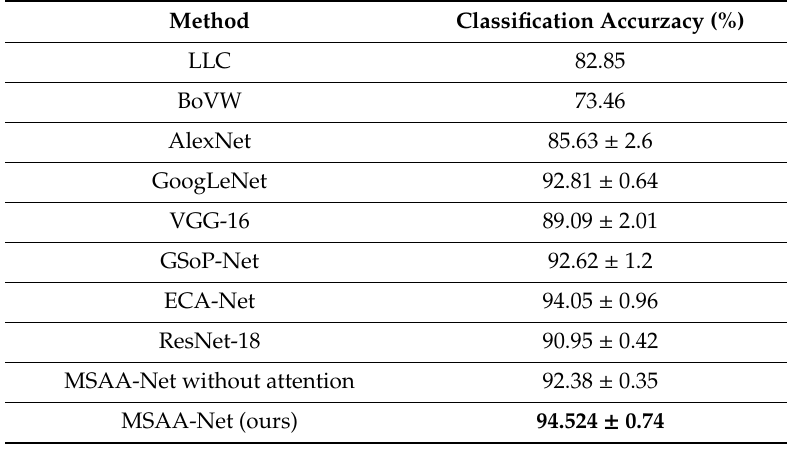
Table 1. Comparison between the previously reported accuracies for the UC Merced